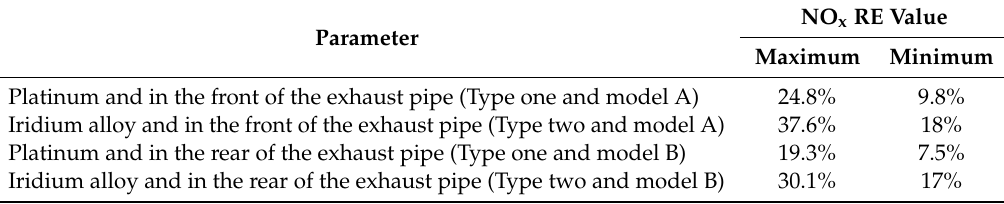
Molecules 2020 , 25 , x FOR PEER REVIEW